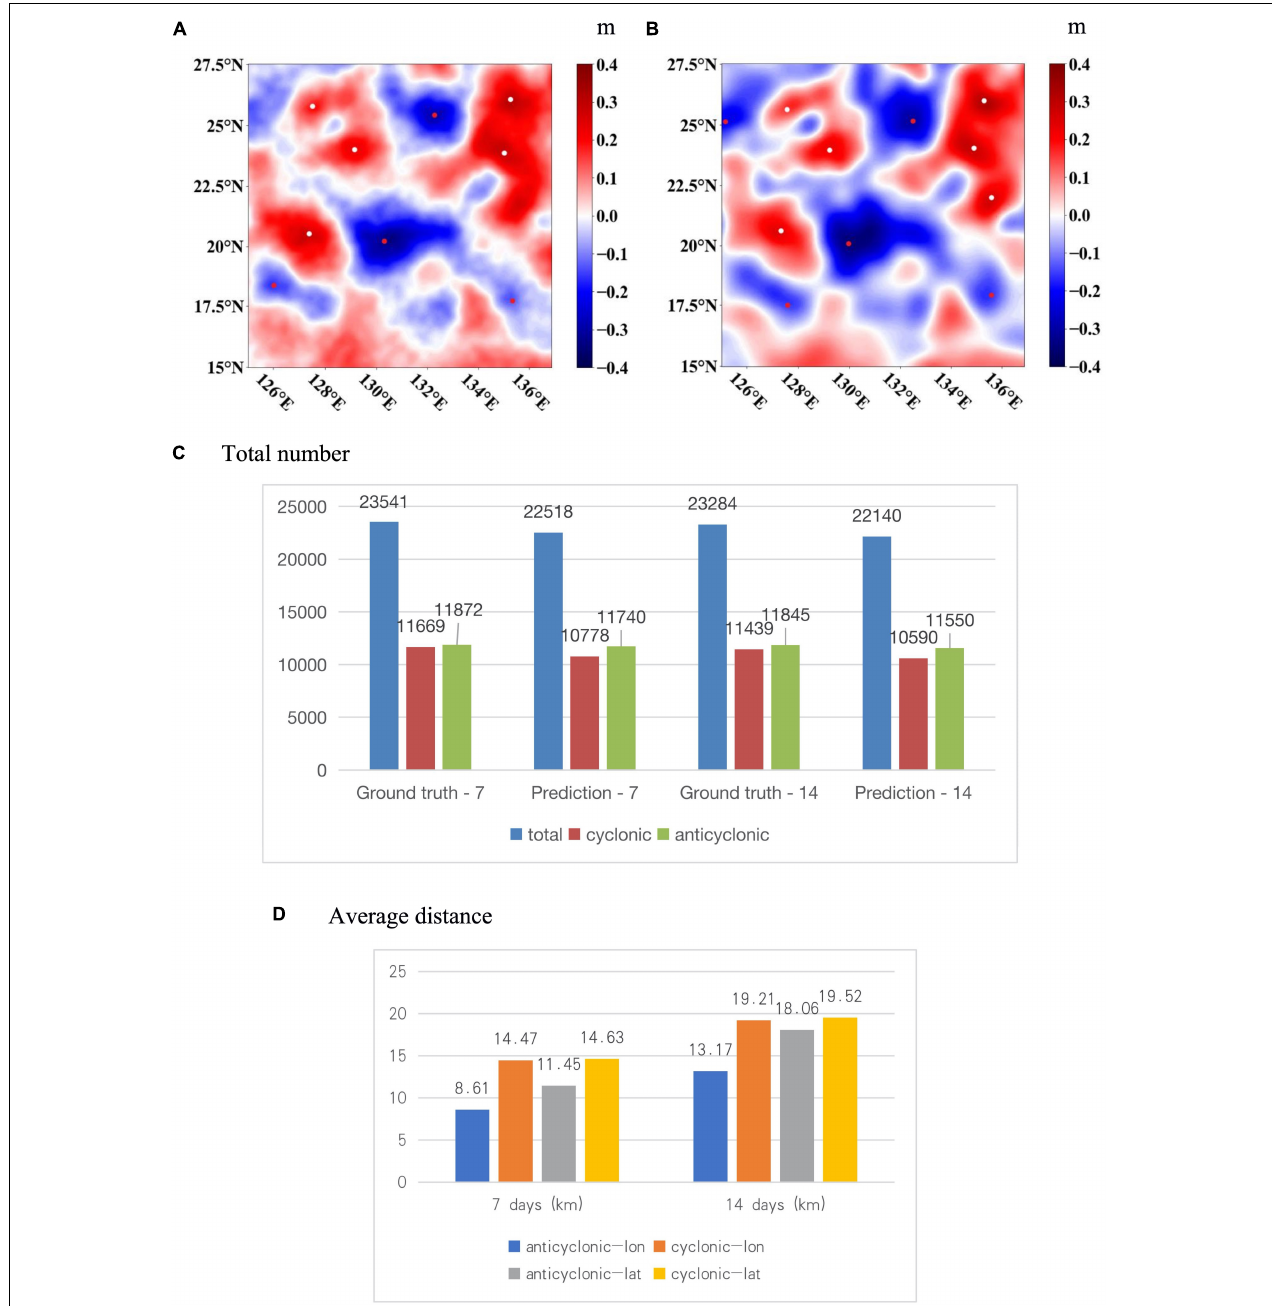
FIGURE 9 | The example mesoscale eddy prediction result and the 7-day and 14-day mesoscale eddy prediction statistics in our study area. (A) Mesoscale eddy detection result from SLA prediction, with the cyclonic center in red and the anti-cyclonic center in white. (B) Mesoscale eddy detection result from SLA ground truth, with the cyclonic center in red and the anti-cyclonic center in white. (C) The number of the detected mesoscale eddies with SLA prediction and SLA ground truth. (D) The average spatial distance in longitude and latitude between the detected center position of mesoscale eddy with SLA prediction and that from SLA ground